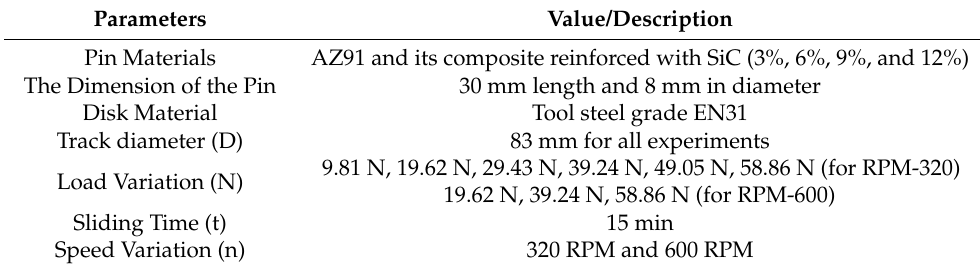
Table 1. Parameters for the pin on disk dry sliding wear test.